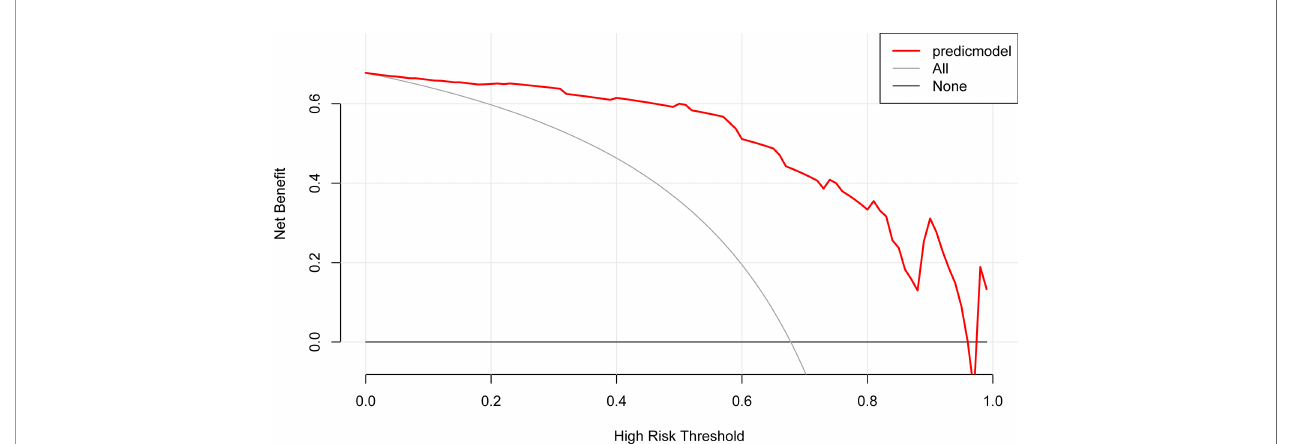
FIGURE 6 | DCA of the nomogram model. The y-axis represents the net bene fi t. The red line represents the predictive APA nomogram model. The gray line represents the assumption that all patients have APA. The black line represents the assumption that no patients have